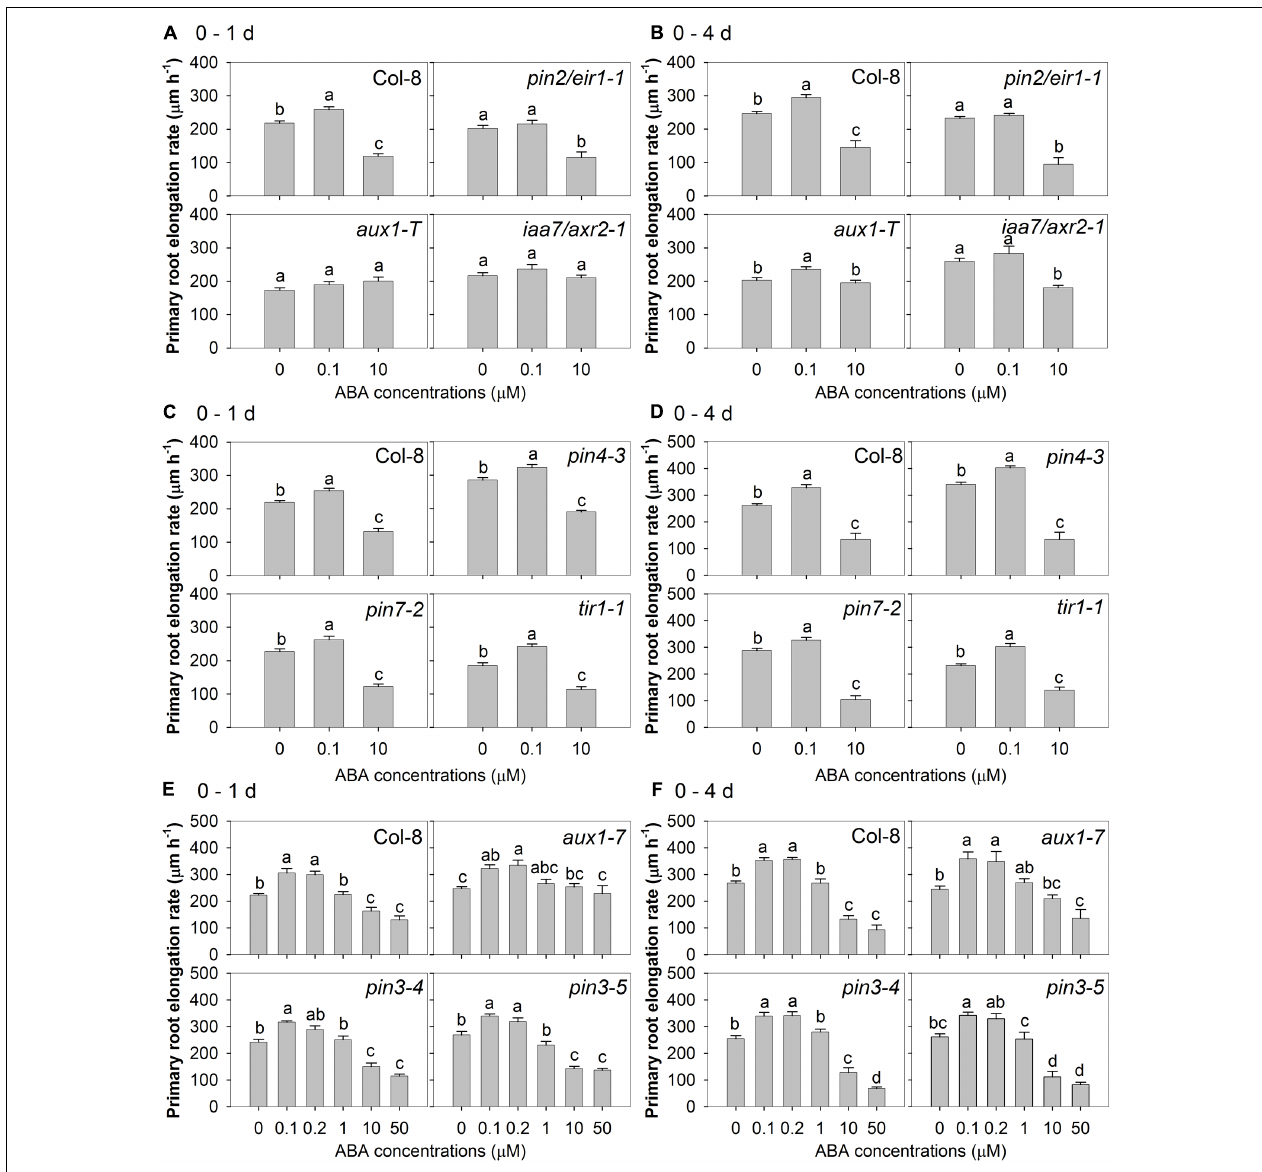
FIGURE 5 | Auxin relevant mutants showed both auxin signalling and auxin transport are required for root growth response to ABA treatments. Primary root elongation rate after the first 24 h treatment of: (A) wild-type Col-8, pin2/eir1-1 , aux1-T , iaa7/axr2-1 (eta 2 of one-way ANOVA: 0.835, 0.517, 0.118, 0.087); (C) Col-8, pin4-3 , pin7-2 , tir1-1 (eta 2 of one-way ANOVA: 0.798, 0.840, 0.808, 0.798); (E) Col-8, aux1-7 , pin3-4 , pin3-5 (eta 2 of one-way ANOVA: 0.773, 0.419, 0.854, 0.881). Average primary root elongation rate over the 4-day treatment of: (B) Col-8, pin2/eir1-1 , aux1-T , iaa7/axr2-1 (eta 2 of one-way ANOVA: 0.740, 0.724, 0.324, 0.616); (D) Col-8, pin4-3 , pin7-2 , tir1-1 (eta 2 of one-way ANOVA: 0.790, 0.884, 0.883, 0.828); (F) Col-8, aux1-7 , pin3-4 , pin3-5 (eta 2 of one-way ANOVA: 0.908, 0.705, 0.906, 0.826). A–F were results from three experiments separately. In each experiment, seedlings of each line were germinated, chosen and transferred to medium with various ABA concentrations ( µ M) as described in Figure 1 . Primary root length was marked after transplanting and the increase of primary root were measured every day. The root elongation rate was calculated for 1 and 4 days after treatments on average. The values are means, and the vertical bars represent standard errors of the means. Data analysed using one-way ANOVA with Tukey’s post hoc test and different letters indicate significant differences among ABA treatments in each genotype at P < 0.05. Seedling numbers: (A) n = 12; (B) n = 6–12; (C) n = 12; (D) n = 3–12; (E) n = 8; (F) n = 4–8. Similar experiments were done for at least three times with different mutant combinations and similar results were